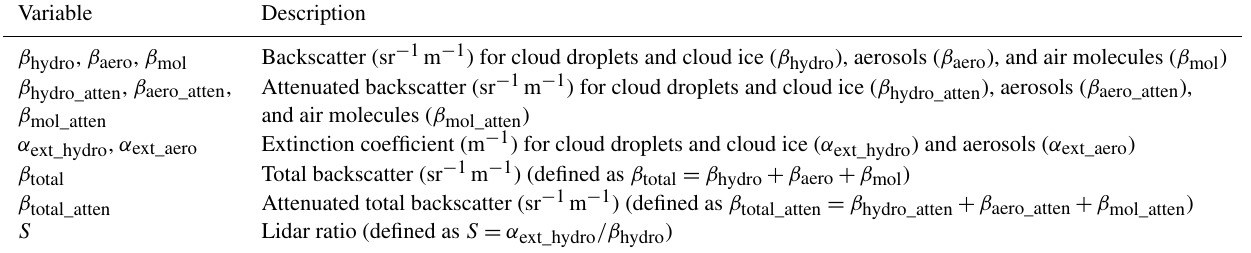
Table 5. Computed lidar variables. Variable